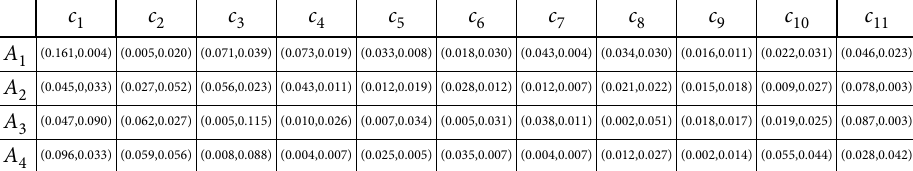
Table 15. The weighted normalized decision matrix c 1 c 2 c 3 c 4 c 5